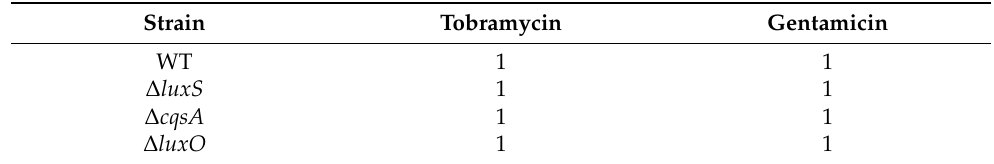
Figure 6. Tolerance of V. cholerae QS mutants to lethal concentrations of aminoglycosides. Bacterial populations were treated with lethal concentrations of tobramycin (20X MIC) and gentamicin (10X MIC) for 4 h. Represented are 10 µ L drops of the indicated dilutions prior treatment (T0) and post treatment (T4). This is a representative experiment of three independent experiments with similar results. Table 2. MIC measured by E-test ( µ